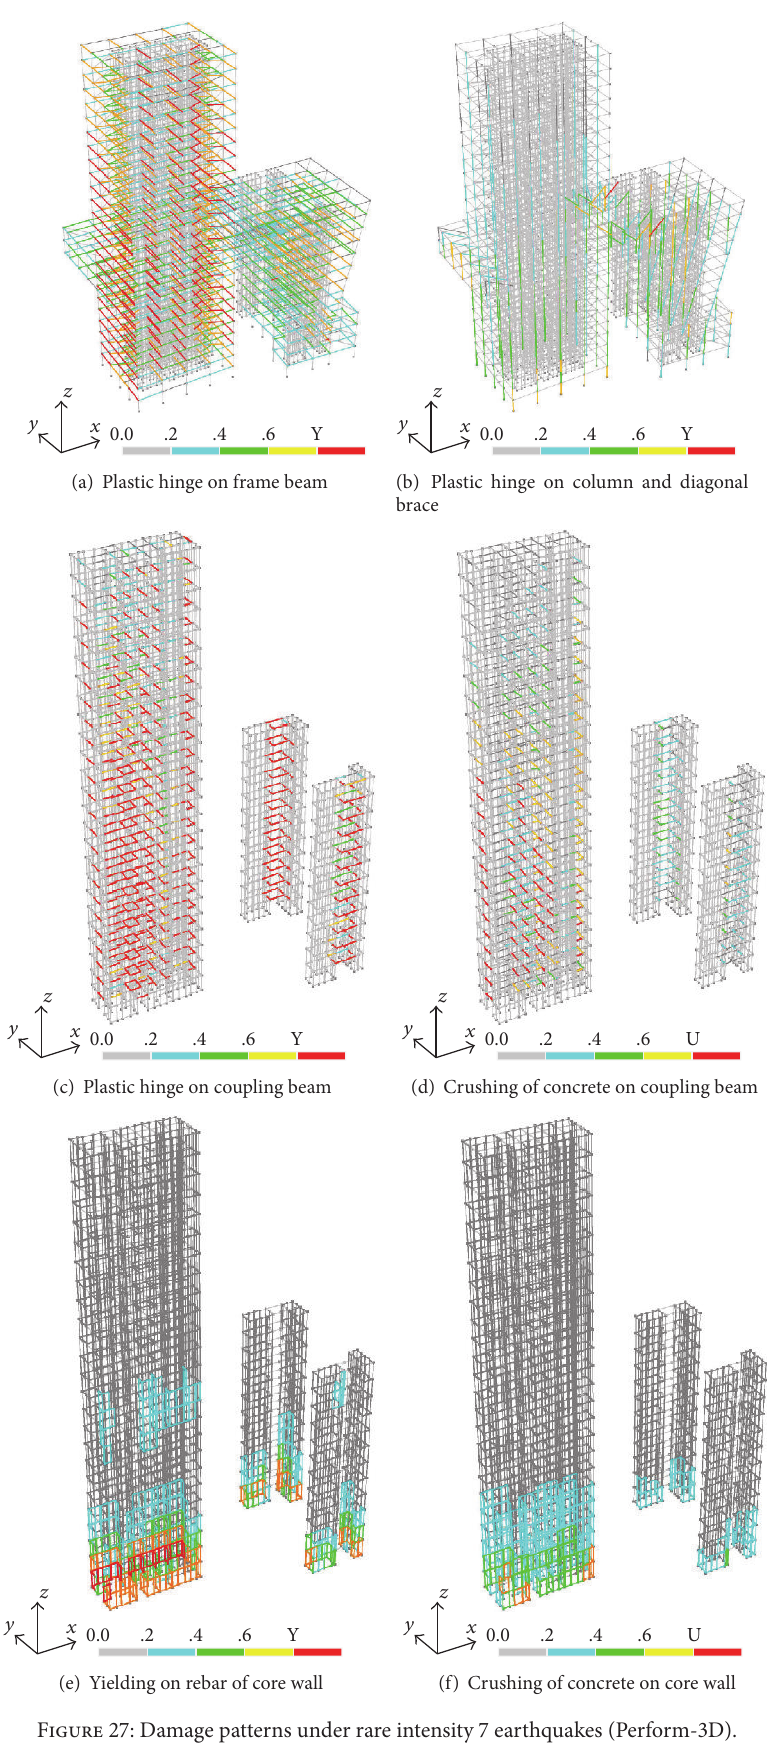
Figure 27: Damage patterns under rare intensity 7 earthquakes